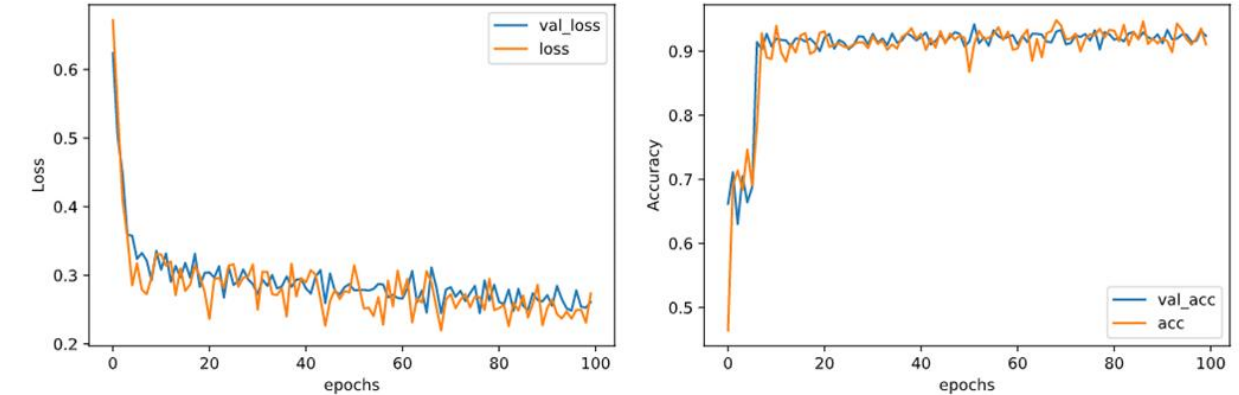
Figure 8. Loss and accuracy plot for FFEDN models obtained on training (shown in orange) and validation set (shown in blue).